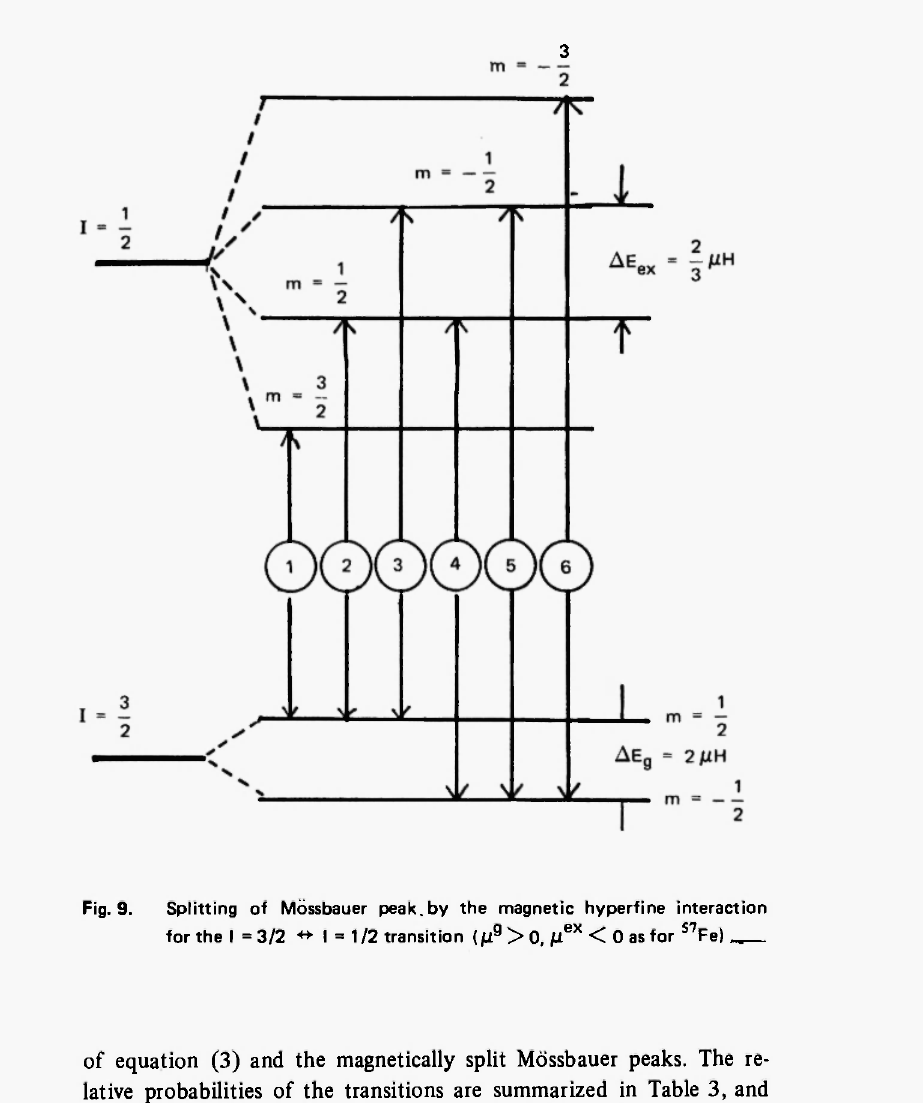
for the I = 3/2 -w 1-1/2 transition (μ 9 > 0, μ βχ < 0 as for S7 Fe)